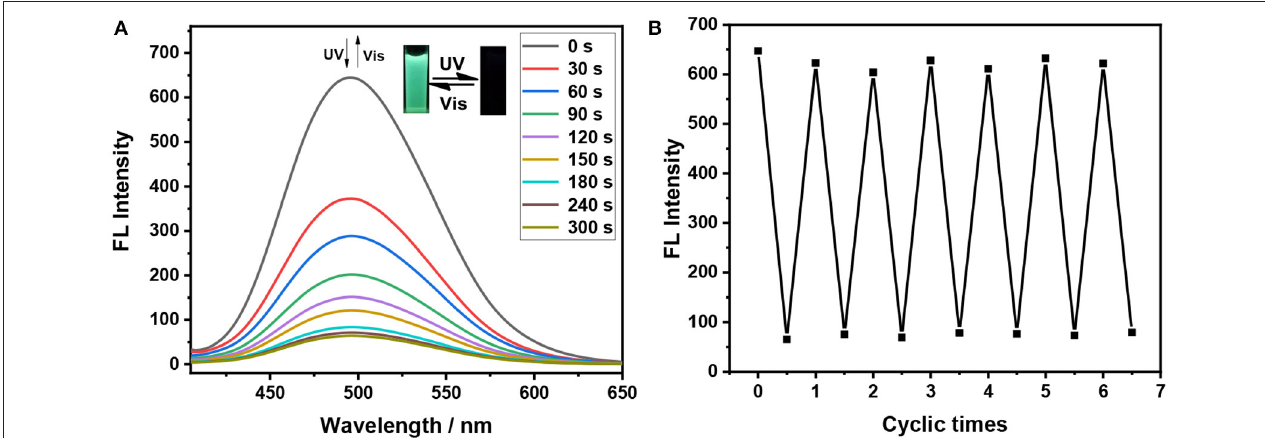
FIGURE 3 | Fluorescence spectra changes of dithienylethene 1 in the mixtures of H 2 O/THF ( f w = 90%) (2 × 10 − 5 mol/L) upon alternating irradiation with UV light (0–300s for the fluorescent-off state, irradiation interval: 30s) at 254nm and visible light at > 402nm (0–450s for the fluorescent-on state, irradiation interval: 50), (A) (Inset) Corresponding fluorescent color changes upon photoirradiation in the powder state; reversible fluorescence switching for 1 in the mixtures of H 2 O/THF ( f w = 90%) (2 × 10 − 5 mol/L), measured at 495nm upon alternating irradiation with UV light at 254nm and visible light at > 402nm (B) .